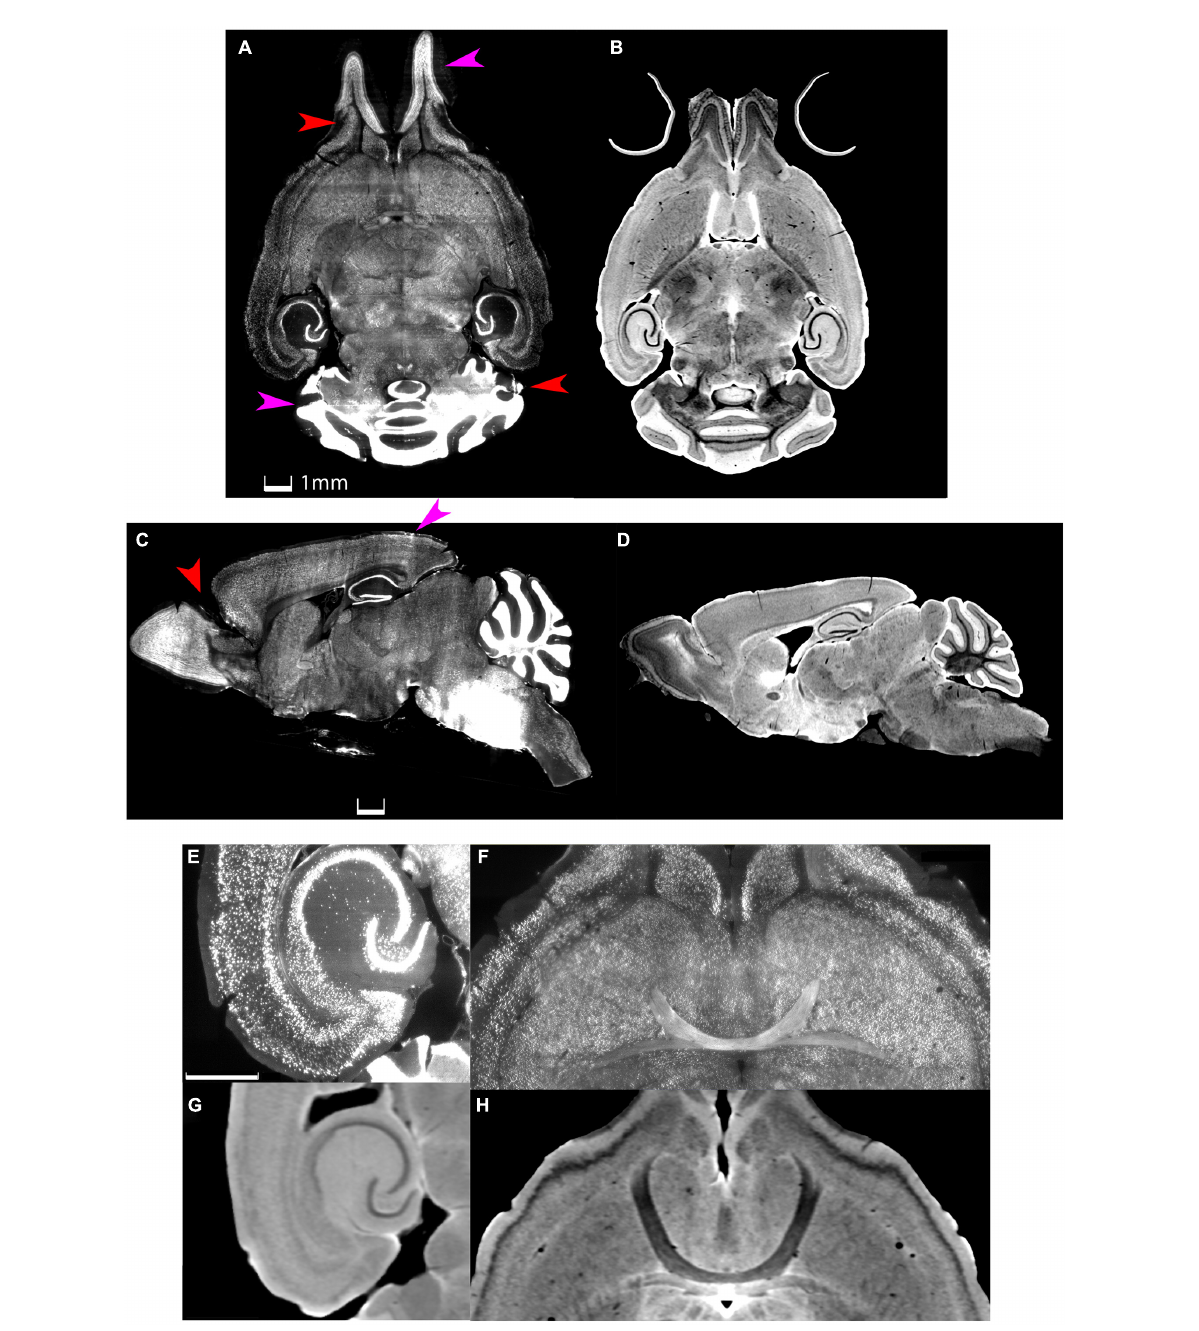
FIGURE1 Distortion and tissue tearing in light sheet microscopy (LSM) compared to magnetic resonance histology (MRH). A comparison between LSM images of a mouse brain stained with NeuN (A,C,E,F) and a diffusion weighted MRH image of the same specimen (B,D,G,H) highlights some of the challenges and opportunities. Red arrows indicate the tissue tearing. Purple arrows indicate the swelling (specimen 200316). Scale bar: 1 mm.